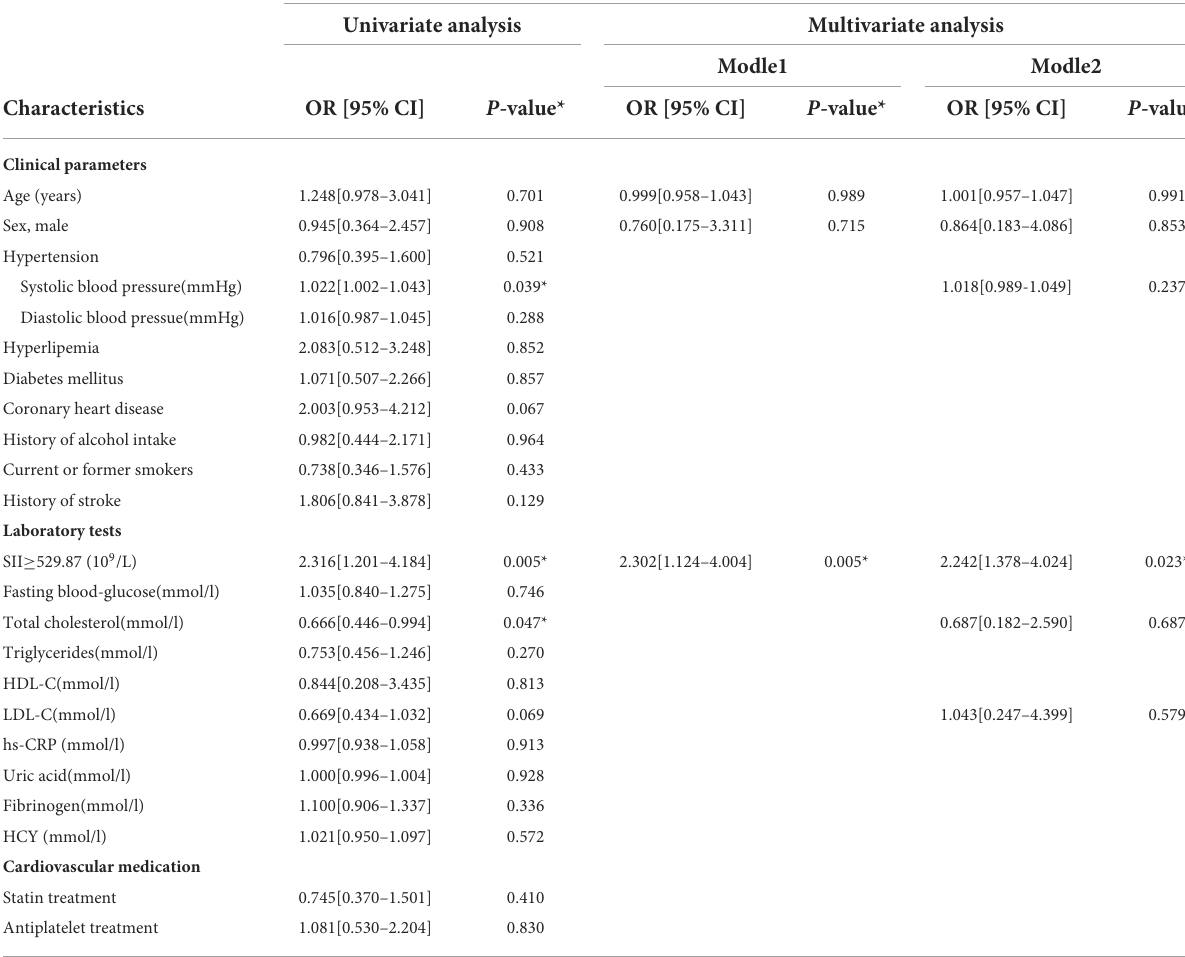
TABLE 3 Univariate and multivariate logistic regression analysis of factors related to vulnerability plaque ( N = 131). Vulnerability plaques presence Univariate analysis Multivariate